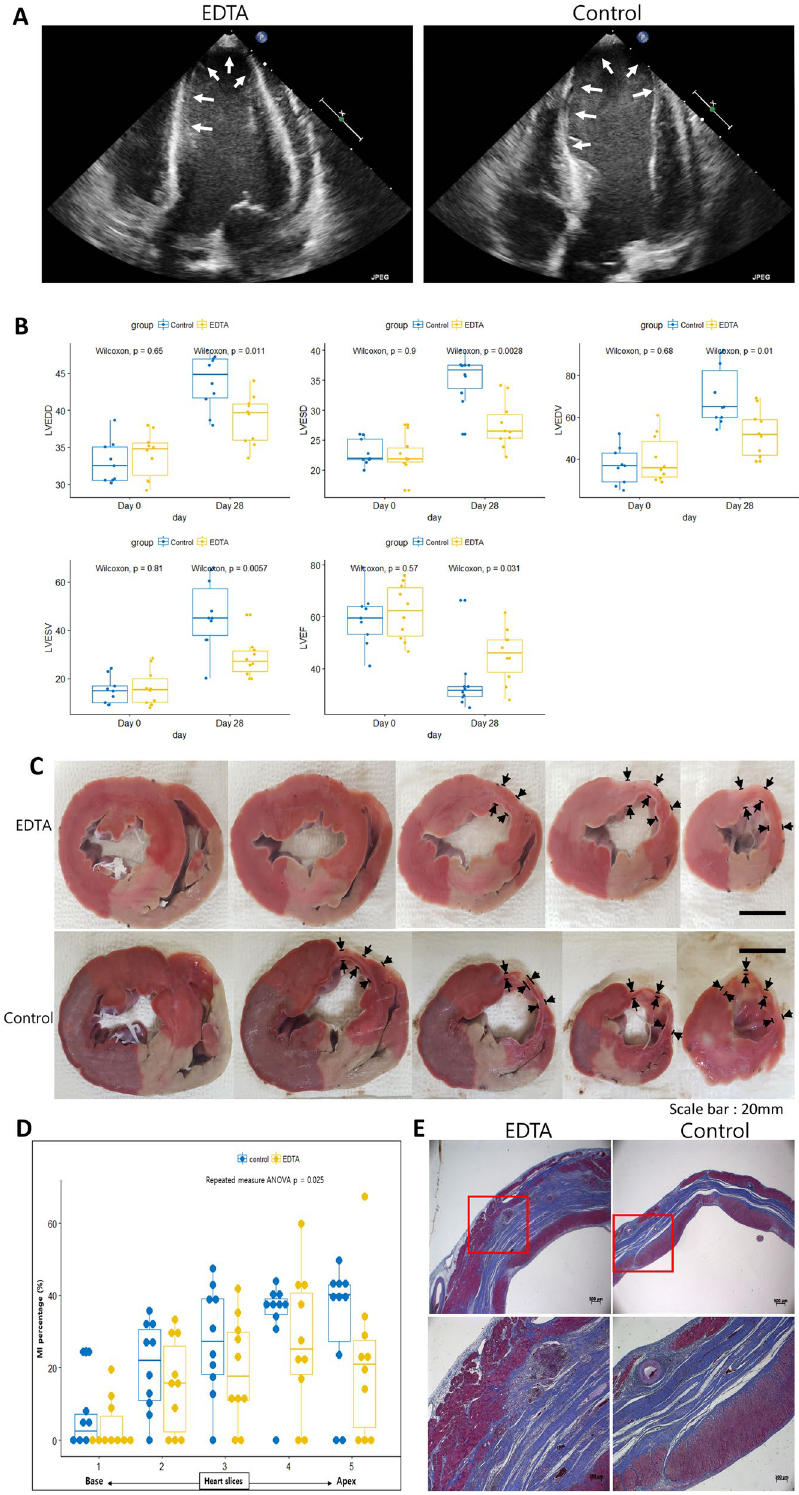
Figure 2. Effect of EDTA on LV remodeling. ( A ) representative echocardiographic view of the infarcted heart on day 28. Arrows, infarcted segments ( B ) The difference between left ventricular end-diastolic diameter (LVEDD), left ventricular end-systolic diameter (LVESD), left ventricular end-diastolic volume (LVEDV), left ventricular end-systolic volume (LVESV), and left ventricular ejection fraction (LVEF) by volumetry at baseline and on day 28. ( C ) Representative heart slices for the pathologic evaluation of post-infarct remodeling. Arrows indicate infarcted segments and thickness of segments. ( D ) Percentage of infarcted area in the slices. ( E ) Representative images of Masson’s trichrome staining of the infarcted segment in each group. Rectangles in the upper panel coincide with the lower